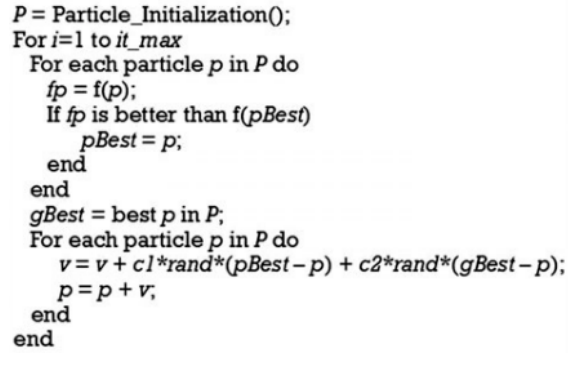
Figure 5. The Pseudo-Code for the PSO algorithm.